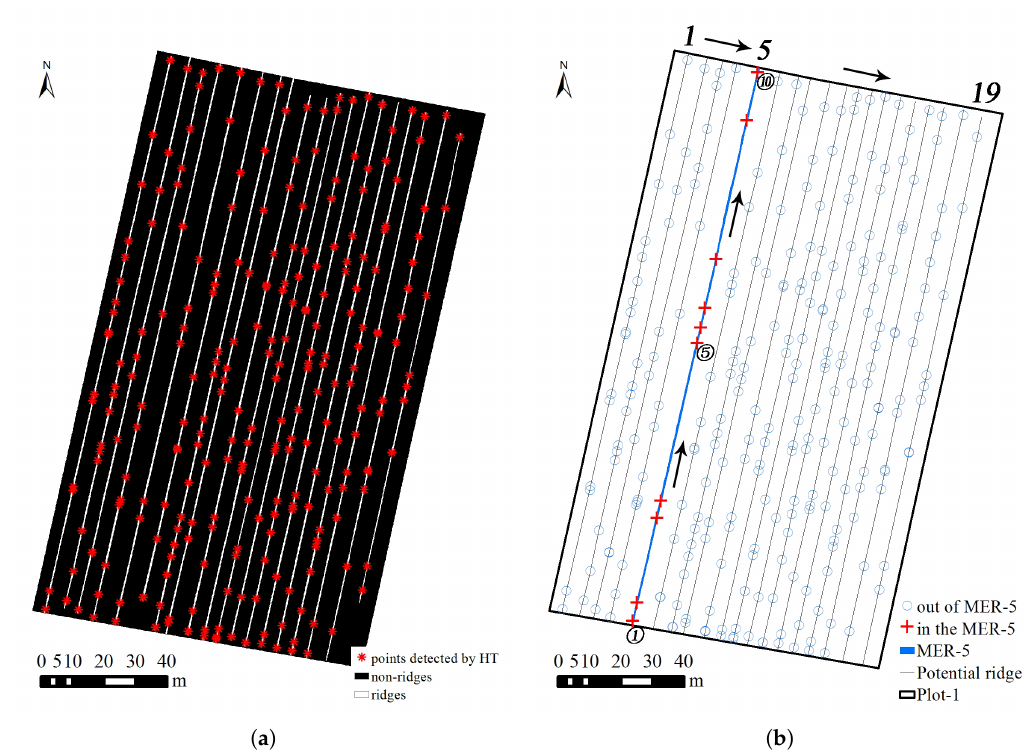
Figure 12. Point detection using the Hough Transform and point labeling and sorting. The binary image of the ridge candidates is the background. ( a ) result of point detection using Hough Transform for Plot 1; ( b ) point labeling and